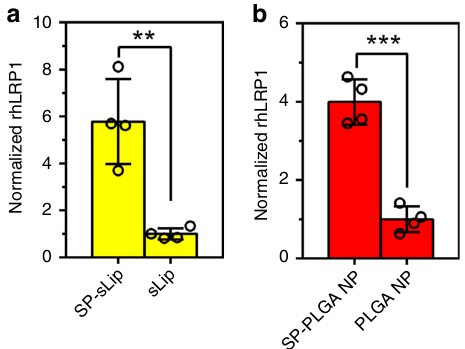
Fig. 8 Characterization of ApoE function in protein corona formed in human plasma. sLip and SP-sLip ( a ), or plain PLGA nanoparticles (PLGA NP) and SP-modi fi ed PLGA nanoparticles (SP-PLGA NP) ( b ) were incubated with human plasma for 1 h at 37 °C, then I 125 radiolabeled rhLRP1 was added in the mixture for another 1 h incubation. The radioactivity of liposomes and PLGA nanoparticles after three cycles centrifugation and rinses was counted for detecting the absorbed rhLRP1. Data are means± SD ( n = 4), ** p < 0.01, *** p < 0.001 by student ’ s t